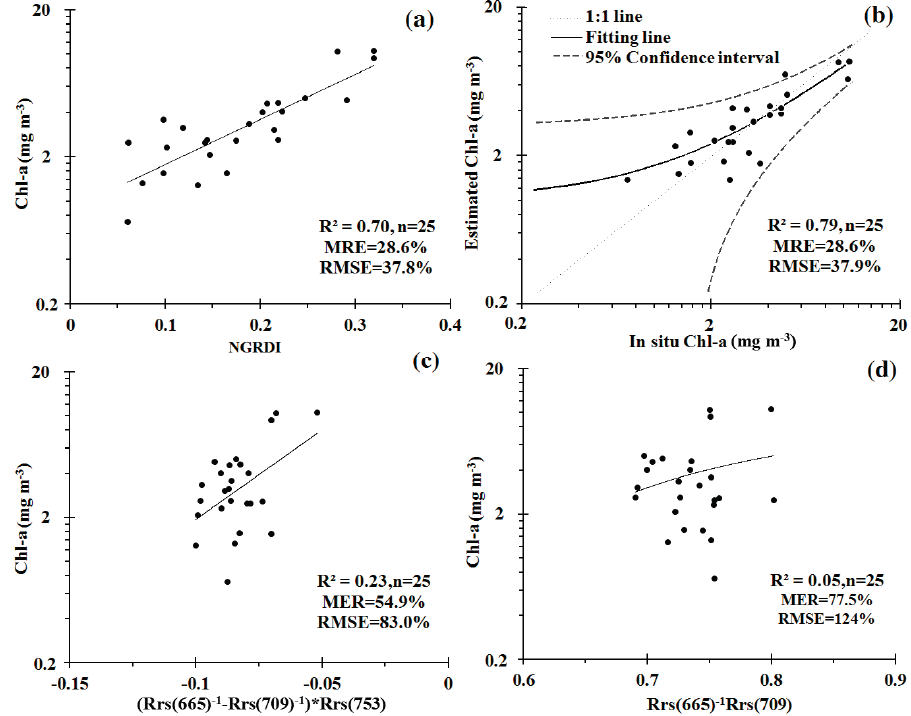
Figure 5. ( a ) The selected empirical NGRDI-Chl-a model and its performance; ( b ) the model performance from the leave-one-out cross-validation (LOOCV) analysis. For comparison, the performances of the three-band and two-band models are shown in ( c ) and ( d ),